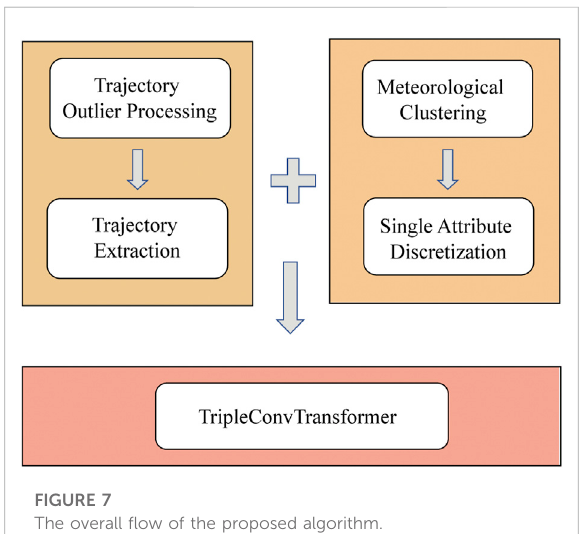
FIGURE 7 The overall fl ow of the proposed